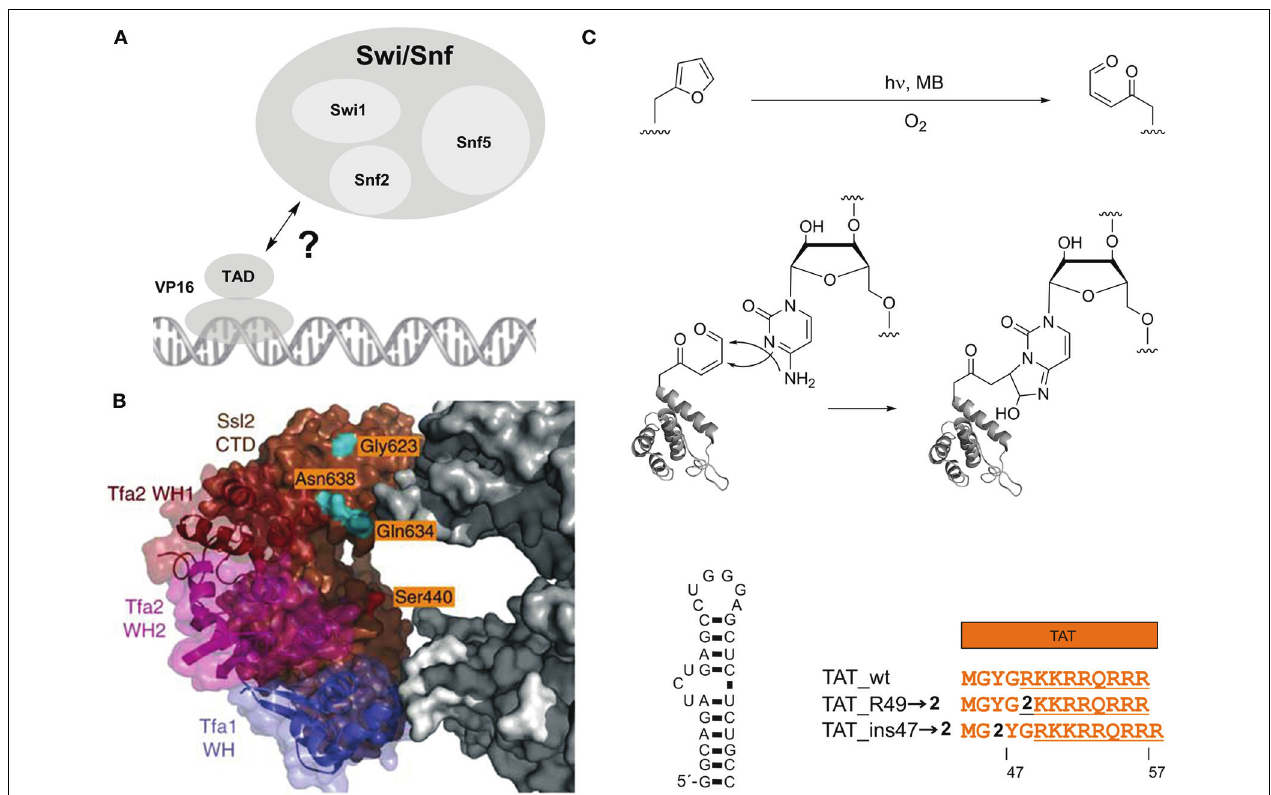
FIGURE 2 | Photocrosslinking studies with an expanded genetic code. (A) Interaction of the prototypical transcriptional activator VP16 with the nucleosome remodeling complex Swi/Snf. (B) Model showing part of the central cleft of RNA polymerase II in the transcription preinitiation complex bound to the general transcrption factors TFIIE and the Ssl2 subunit of TFIIH. Three winged helix (WH) domains of TFIIE are shown in blue, magenta and dark brown, the Ssl2 subunit in light brown. RNA polymerase II is shown in gray, amino acids analyzed in photocrosslinking